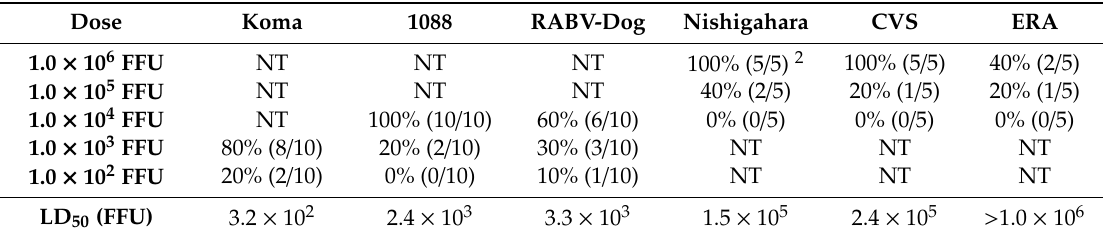
Table 3. Pathogenicity of each of the virus strains in mice after i.m. inoculation 1 . Dose Koma 1088 RABV-Dog Nishigahara CVS ERA